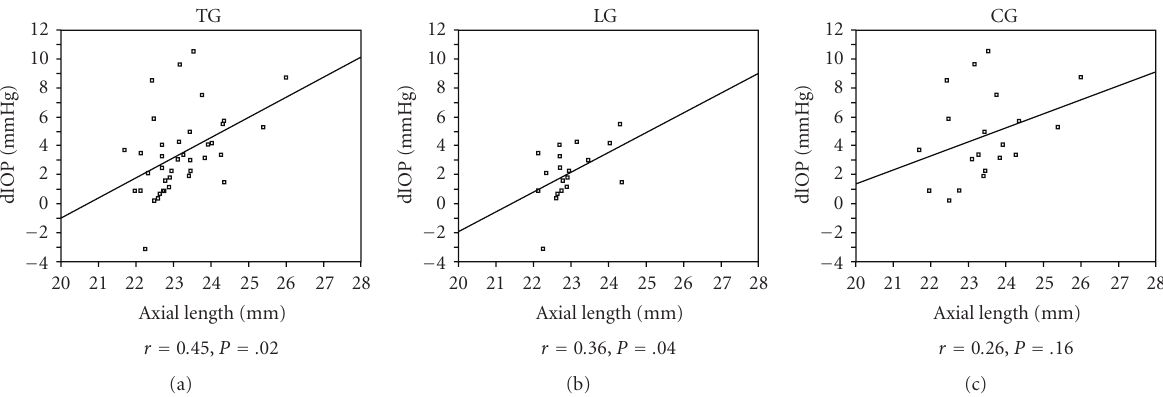
Figure 1: Scattergrams of the correlations between dIOP and AL in the TG (a), LG (b), and CG (c) with respective trend lines, correlation coe ffi cient values and P